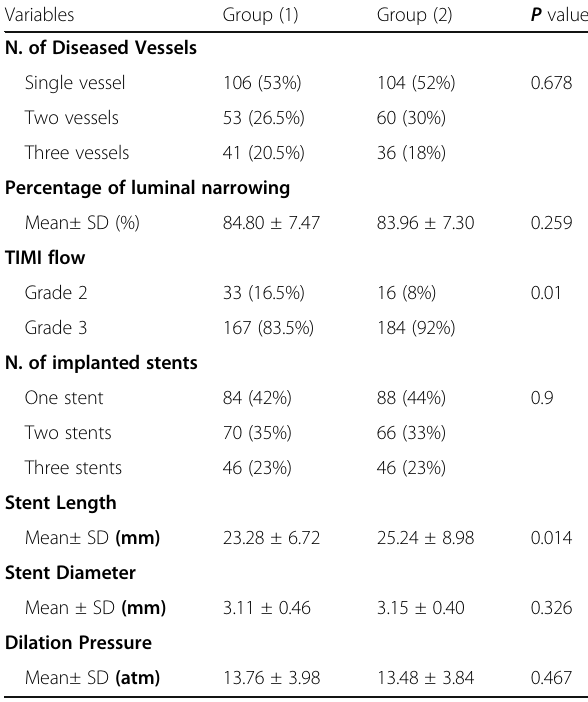
Table 4 Baseline lesion and procedural